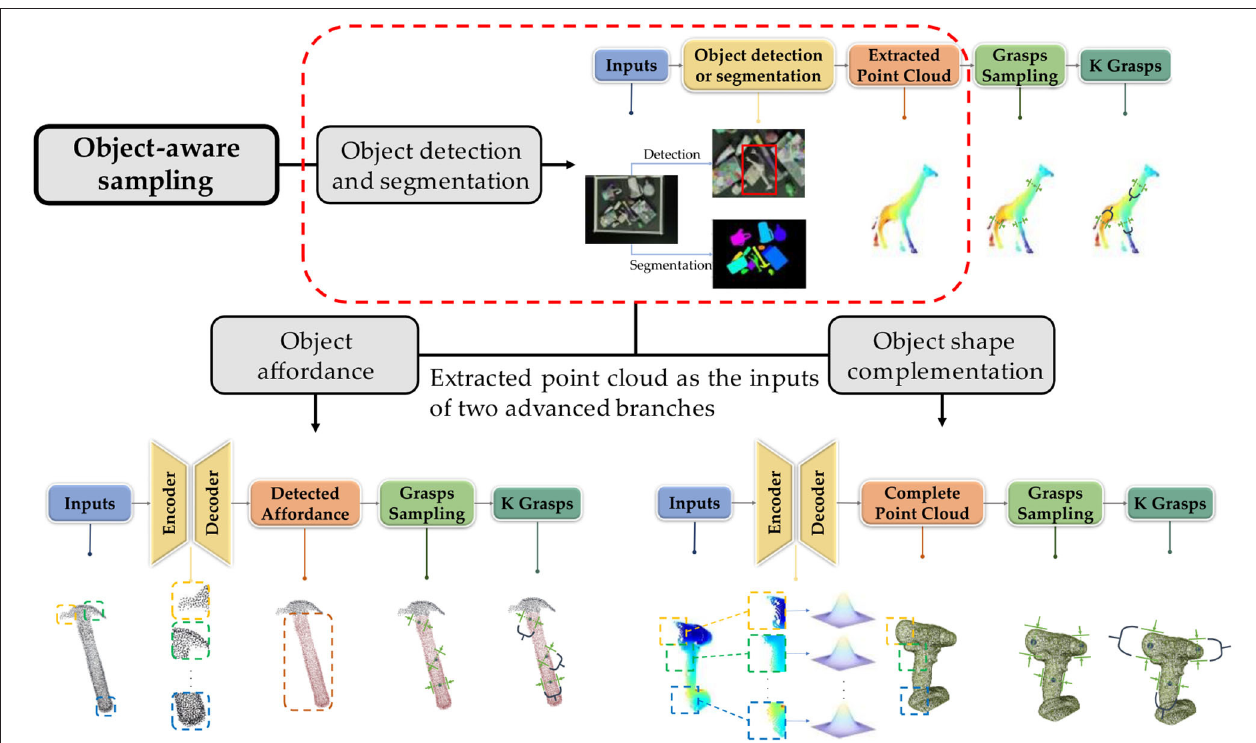
FIGURE 4 | Entire pipelines of three classifications in object-aware sampling. Object detection and segmentation is the most basic method. Inputs are commonly RGB images, which are detected or segmented by networks to extract the object point clouds. Extracted point cloud can either be utilized to sample the grasp candidates immediately or fed into object affordance or shape complementation methods. Object affordance methods take extracted point cloud as inputs to obtain the affordance of object to reduce the sampling search space. On the contrary, object shape complementation aims to acquire the entire object point cloud to improve the grasp candidate generation confidence (The hammer point cloud is from YCB